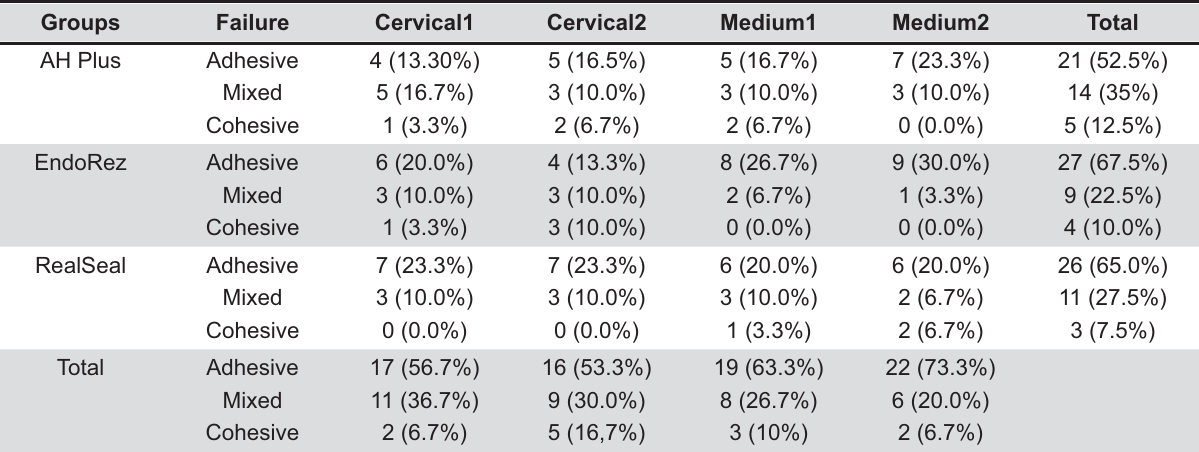
Table 3- (cid:12)*(cid:6)(cid:8)(cid:9)(cid:31)(cid:4)(cid:3)(cid:12)(cid:5)"(cid:25)(cid:3)&(cid:12)(cid:23)(cid:12)(cid:13);(cid:20)&(cid:12)(cid:21)(cid:8)(cid:22)(cid:22)(cid:3)(cid:4)(cid:3)(cid:23)(cid:10)(cid:12)(cid:9)(cid:3)(cid:10)(cid:10)(cid:3)(cid:4)(cid:24)(cid:12)(cid:8)(cid:23)(cid:25)(cid:8)(cid:26)(cid:6)(cid:10)(cid:3)(cid:12)(cid:24)(cid:8)(cid:27)(cid:23)(cid:8)(cid:28)(cid:26)(cid:6)(cid:23)(cid:10)(cid:12)(cid:25)(cid:8)(cid:22)(cid:22)(cid:3)(cid:4)(cid:3)(cid:23)(cid:26)(cid:3)(cid:24)(cid:12)(cid:8)(cid:23)(cid:12)(cid:29)(cid:30)(cid:31)(cid:24)(cid:19)!"(cid:31)(cid:10)(cid:12)(cid:24)(cid:10)(cid:4)(cid:3)(cid:23)(cid:27)(cid:10)(cid:19)(cid:12)#(cid:6)(cid:9)(cid:31)(cid:3)(cid:24)(cid:12)(cid:6)(cid:5)"(cid:23)(cid:27)(cid:12)(cid:4)""(cid:10)(cid:12) levels, for each material and for the whole